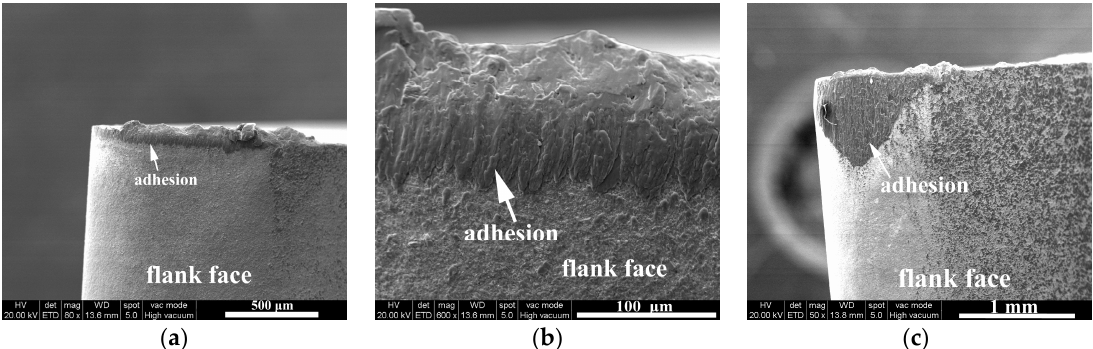
Figure 7. SEM images of flank face of the uncoated insert (K20): ( a ) cutting speed of 50 m/min, cutting time of 3 min; ( b ) magnification of adhesion in Figure 7a; and ( c ) cutting speed of 60 m/min, cutting time of 6 min; (feed rate of 0.1 mm/r and depth of cut of 1.0 mm for ( a – c )).